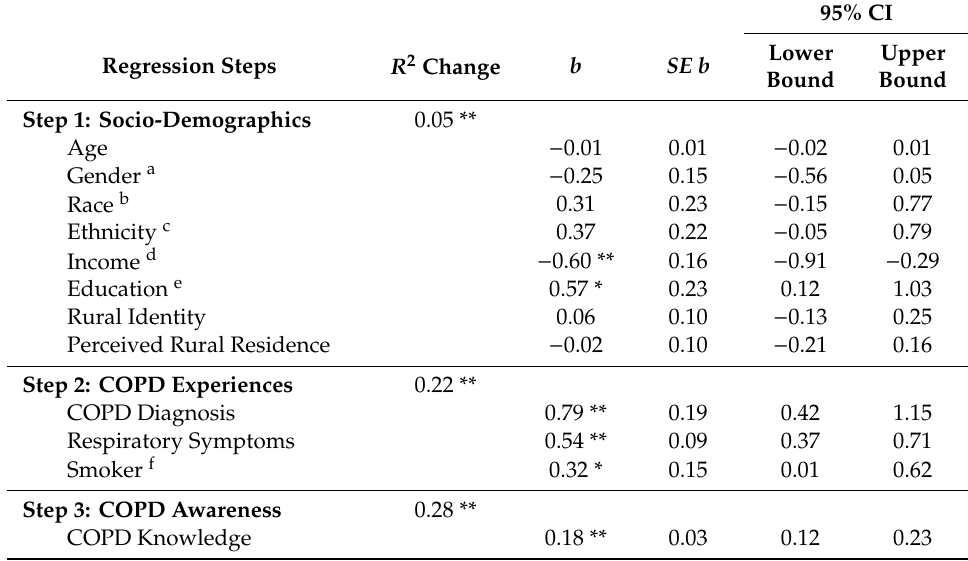
Table 2. Hierarchical linear regression of factors contributing to COPD illness identity.